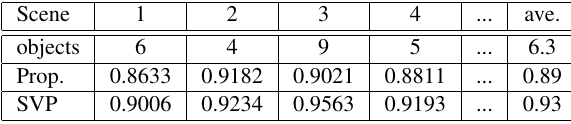
Table 1: Test scenes and evaluations (accuracy) in comparison to the work of Endres and Hoiem (2010).